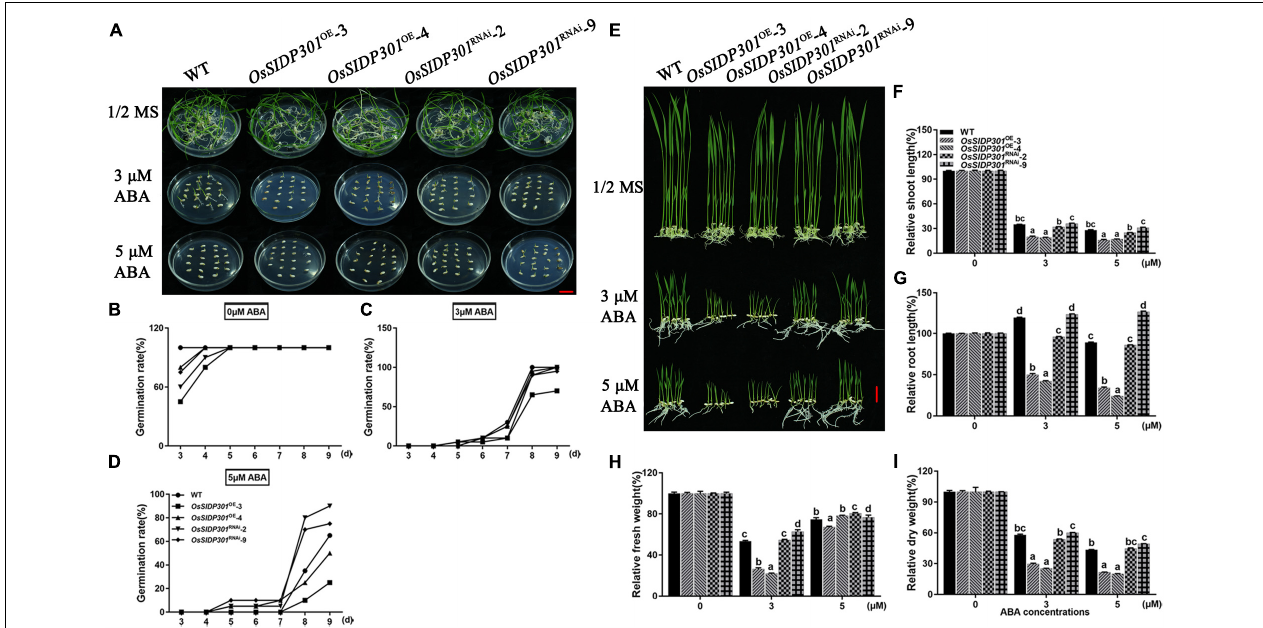
FIGURE 7 | Phenotype of OsSIDP301 transgenic plants with ABA treatment. (A) Phenotype of OsSIDP301 transgenic plants with ABA treatment at germination stage, bar = 2 cm. Comparisons germination rate between WT, OsSIDP301 OE , and OsSIDP301 RNAi plants with (C,D) or without ABA treatment (B) . (E) Phenotype of OsSIDP301 transgenic plants with ABA treatment at the seedling stage, bar = 2 cm. Comparisons of shoot length (F) , root length (G) , fresh weight (H) , and dry weight (I) between WT, OsSIDP301 OE , and OsSIDP301 RNAi plants with or without ABA treatment for 7 days. Data are shown as mean ± SD ( n = 8), different letters suggested significant differences at P <